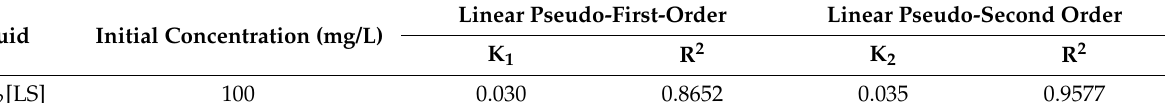
Table 5. Parameters of the kinetic model.